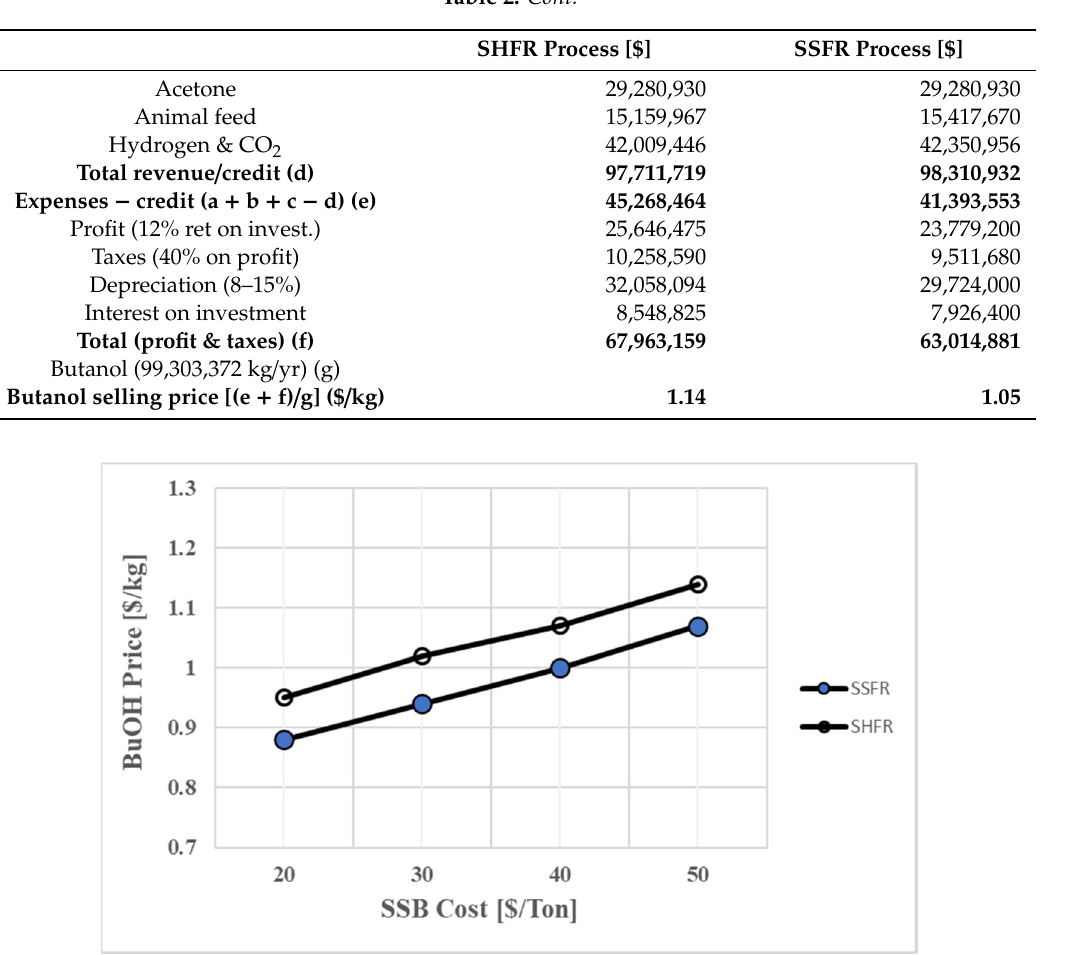
Figure 3. Effect of cost of SSB on the butanol selling price using SHFR and SSFR processes. Figure 3. E ff ect of cost of SSB on the butanol selling price using SHFR and SSFR